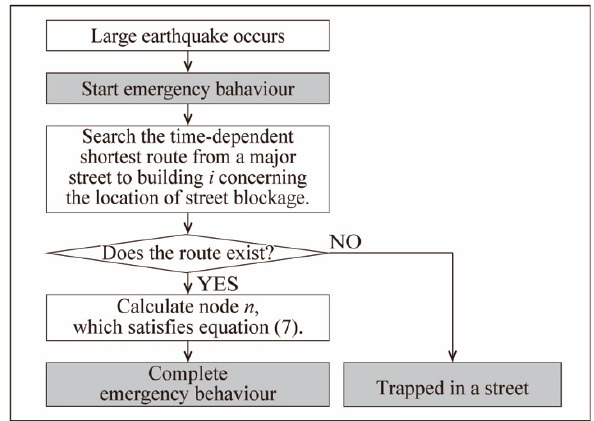
Figure 3. Overview of the emergency behaviour model